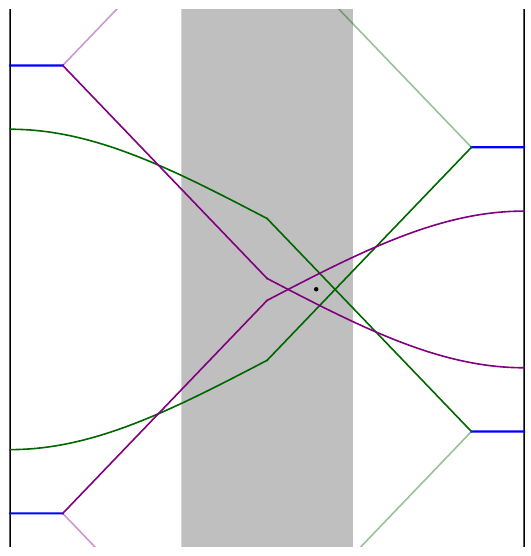
Figure 1. This (cid:12)gure is based on (cid:12)gure 3 of [15] demonstrating how to localise a point inside the entanglement shadow in the conical de(cid:12)cit spacetime. It depicts a conformal diagram, where light rays move at 45 (cid:14) , of a ( r; t ) slice of this spacetime with de(cid:12)cit angle 2 (cid:25)= 3. The entanglement shadow is shown in gray. Four HRT surfaces associated to large boundary regions are drawn in blue. The boundaries of the corresponding entanglement wedges are shown, in green and purple for HRT surfaces centered at (cid:18) = 0 and (cid:18) = (cid:25) respectively. This boundary is set by a light ray departing the HRT surface and reaching the defect at r = 0. Behind the defect a caustic forms reaching the boundary at the other side of the cylinder. Provided that the corner between the light ray and the caustic is not too sharp, one can use such a set of boundary regions to localise a point in the entanglement shadow of a conical